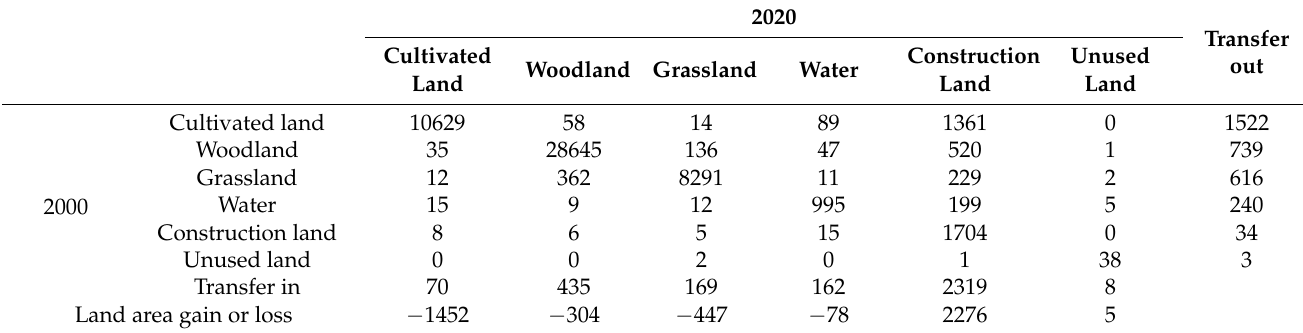
Table A5. Landscape type transition matrix in coastal areas of Fujian from 2000 to 2020/km 2